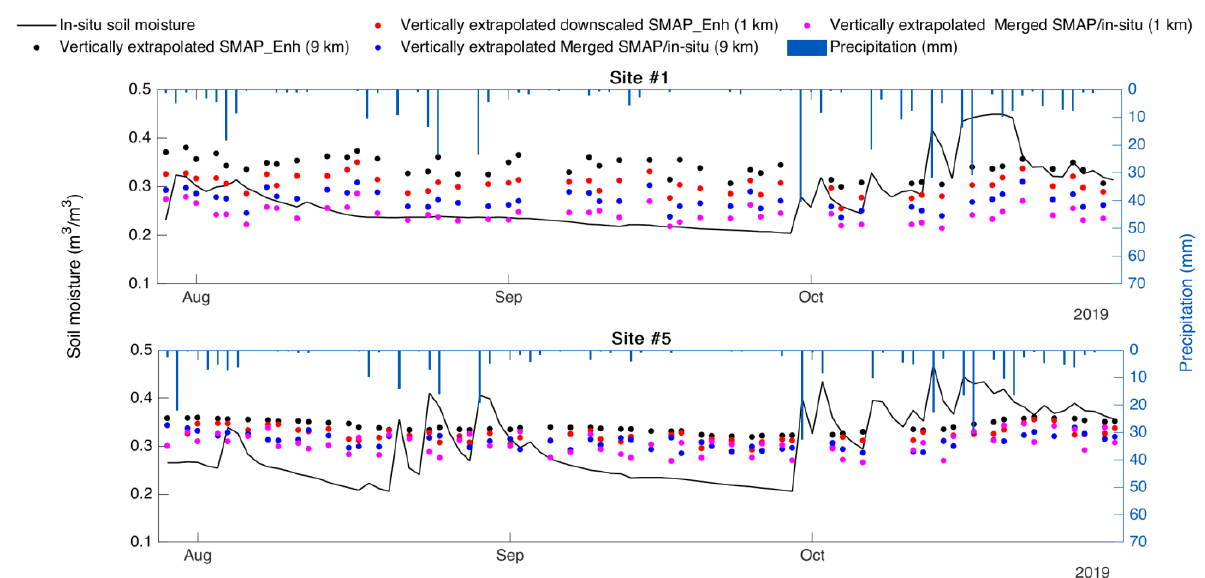
Figure 6. Time series comparison of in-situ soil moisture with vertically extrapolated SMAP (i.e., downscaled and its original counterparts) and merged SMAP/in-situ soil moisture at 1 and 9 km for two selected sites.